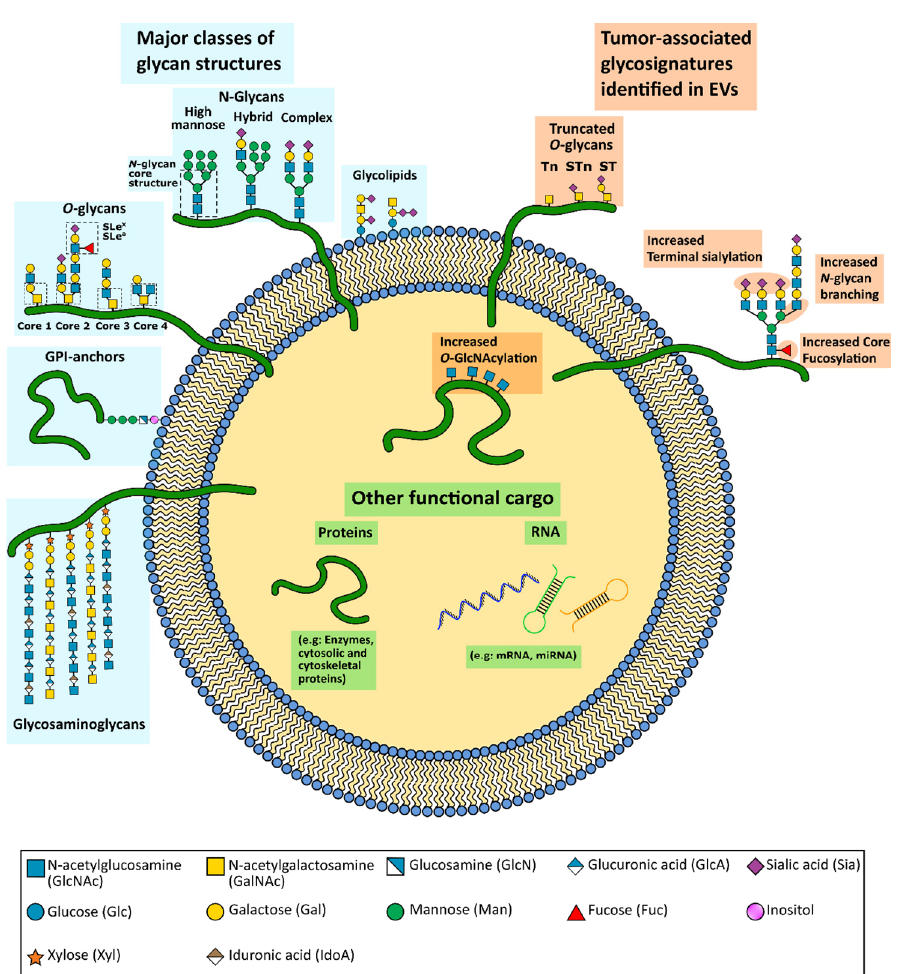
Figure 1. Schematic representation of an extracellular vesicle (EV) and its functional cargo. EVs carry a wide variety of functional molecules, including glycoproteins and glycolipids. The major common classes of glycoconjugates found in human cells are depicted on the left. Aberrant tumor-associated glycosylation already identified in cancer EVs are depicted on the right. The glycostructures were represented at the expected EV localization (intern or at the EV membrane) considering the knowledge from the cell glycans. Nevertheless, the specific localization of some of these structures is not yet fully elucidated.